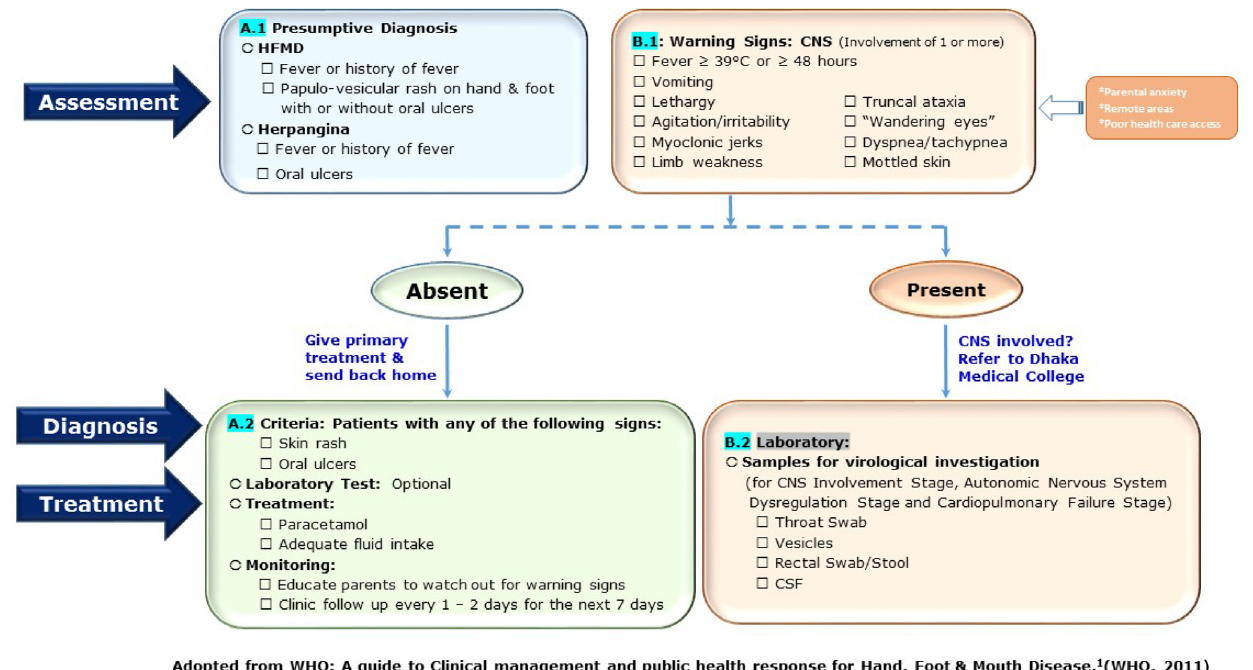
Figure 4. Decision tree for the clinical diagnosis and management of hand, foot and mouth